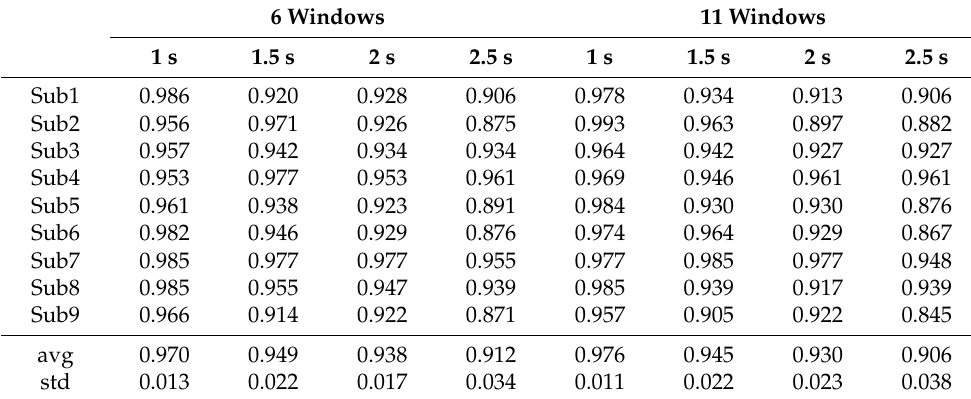
Table 1. The validation accuracy for ED algorithm.